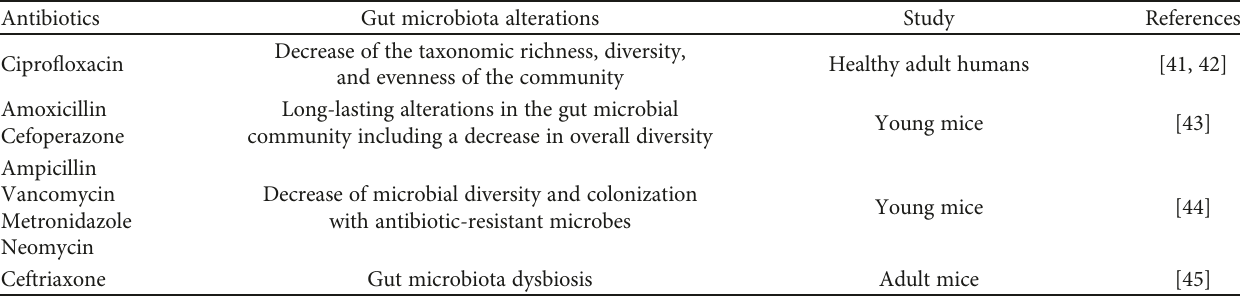
Table 2: Gut microbiota alterations induced by antibiotic